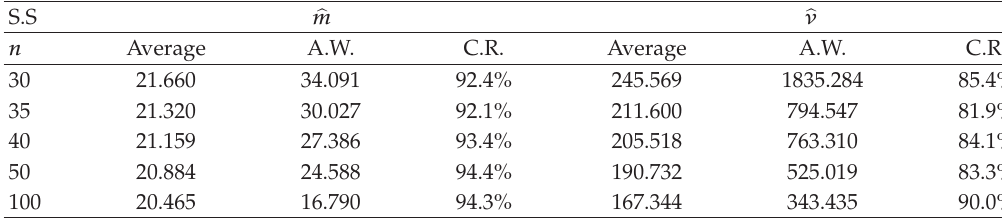
Table 2: Grouped data: τ 1 (cid:8) 1 . 5, τ 2 (cid:8) 2 . 5, τ 3 (cid:8) 3 . 5, τ 4 (cid:8) 4 . 5, τ 5 (cid:8) 5 . 5.